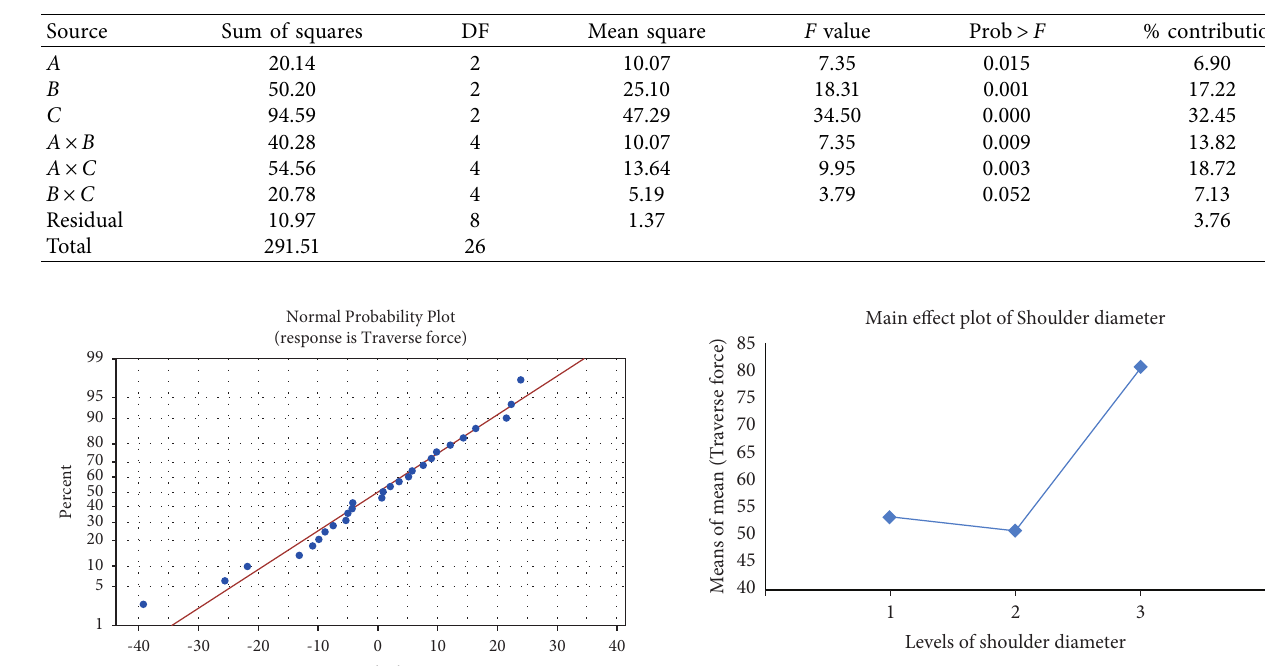
Figure 9: Main effect plot of shoulder diameter for means (traverse force). Figure 6: Normal probability plot for the values of traverse